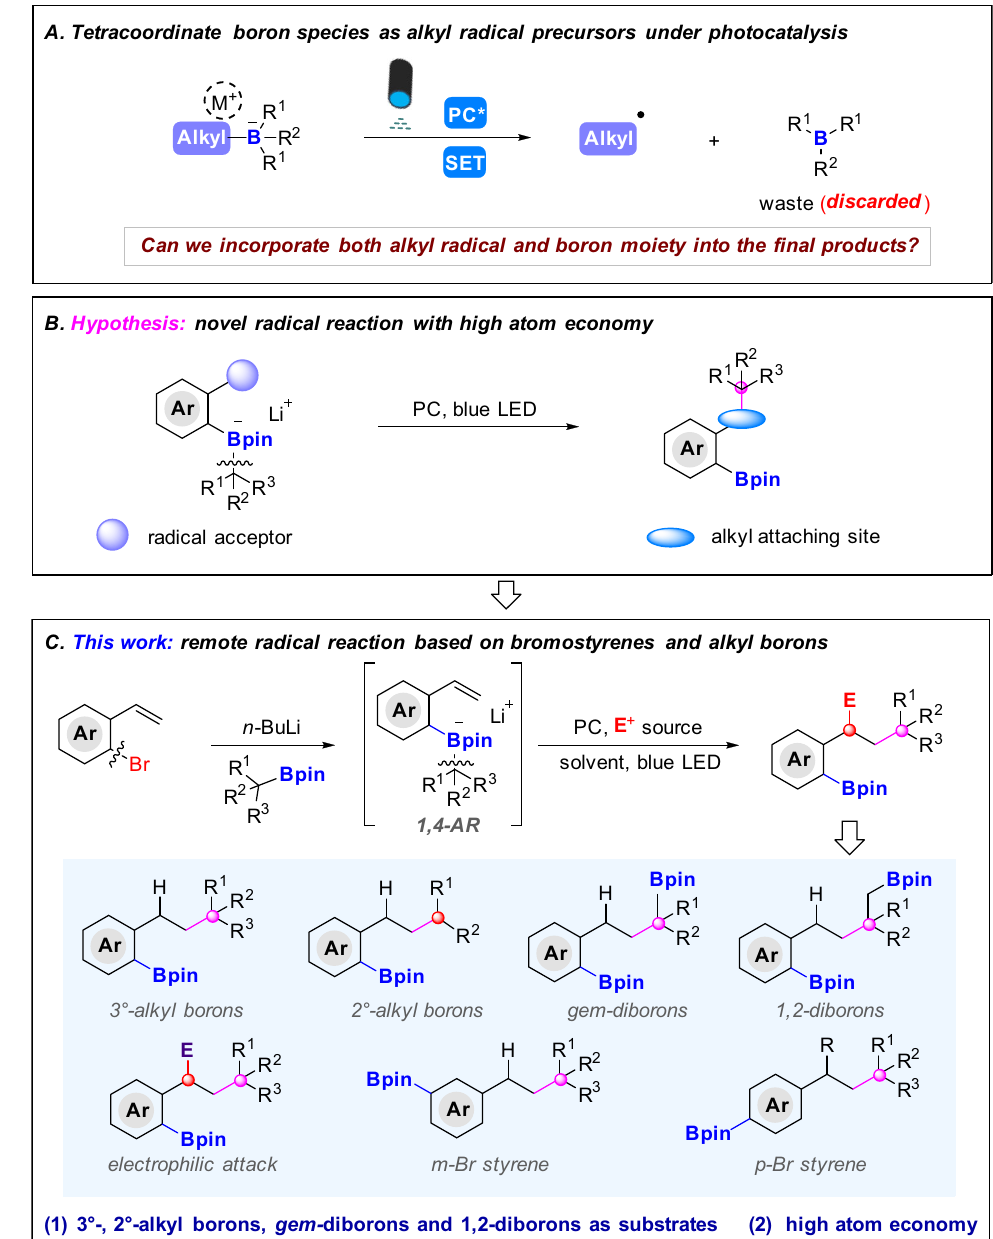
Fig. 1 Alkyl radical precursors based on tetracoordinate boron species and radical migration reactions. A Tetracoordinate boron species as alkyl radical precursors under photocatalysis. B Hypothesis: remote radical migration reaction with high atom economy. C Remote radical migration reaction based on bromostyrenes and alkyl borons (this work). Bpin = boronic acid pinocol